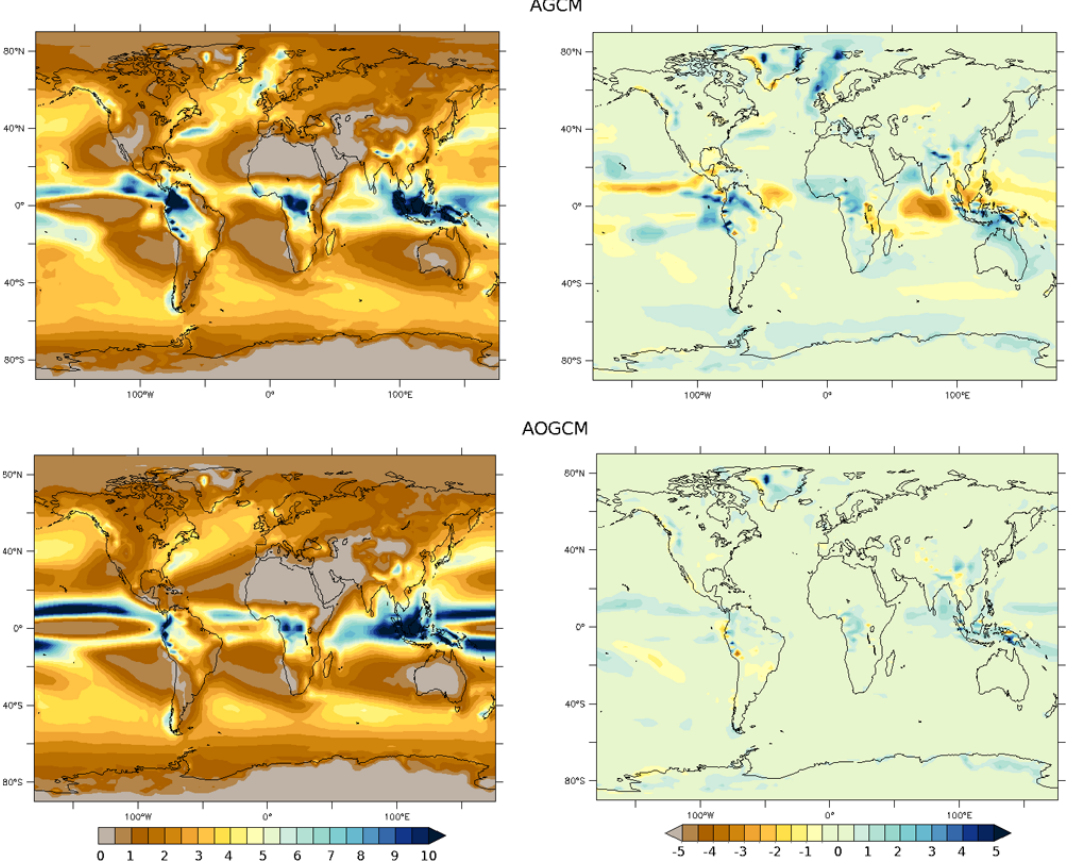
Fig. 11. Mid-Pliocene mean annual precipitation (left) for AGCM (top) and AOGCM (bottom), and their anomaly to the control (right), expressed inmmday − 1